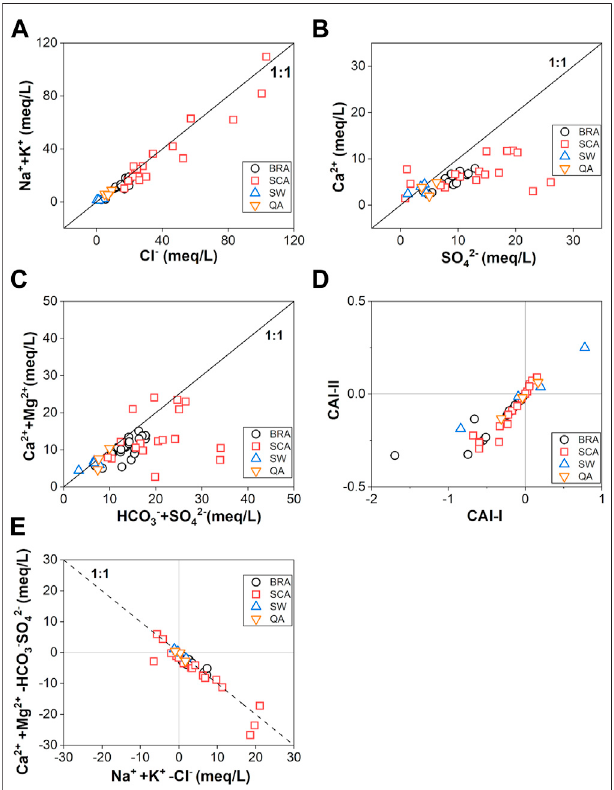
FIGURE 8 | Scatter plots of some pairs of ions (A) Cl − and Na + +K + ; (B) SO 42 − and Ca 2+ ; (C) HCO 3 − +SO 42 − and Ca 2+ +Mg 2+ ; (D) CAI-I and CAI-II;